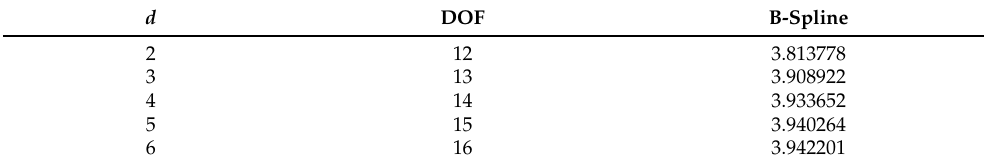
d = 5 d = 6 Figure 10. Time history of the relative error between transient and stationary solution in H 0 ( Γ ) norm for increasing degrees of B-spline shape functions on a uniform spatial discretization of size ∆ α = π /10. The time interval [ 0,1200 ] is decomposed in 8000 time steps.